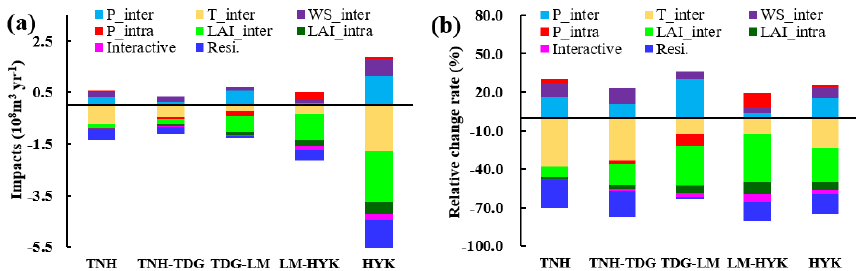
Figure 9. (a) Impacts and (b) relative impact rates of the different influencing factors on the annual streamflow trends in different drainage areas over the